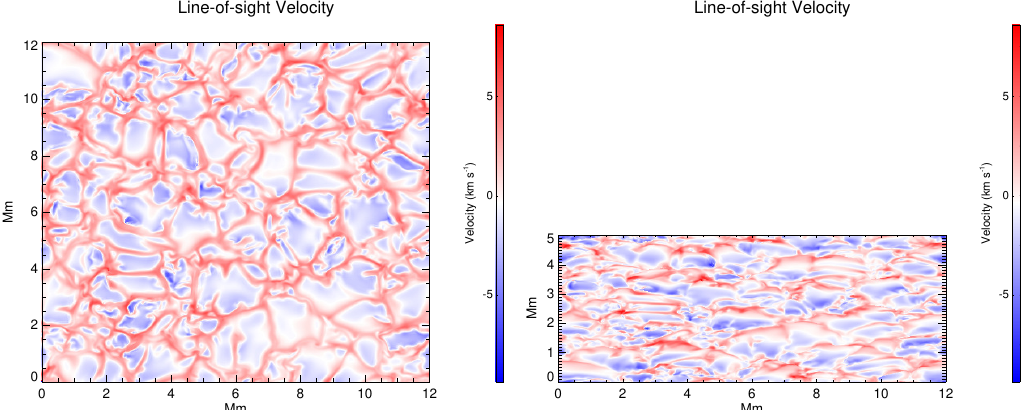
Figure 2. Line-of-sight RVs for a 3D MHD simulation snapshot at disc center (left) and µ = 0.5 (i.e., 60 ◦ ; subset of Figure 1 in [35]). Negative and positive velocities denote blueshifts and redshifts, respectively. c (cid:13) AAS. Reproduced with